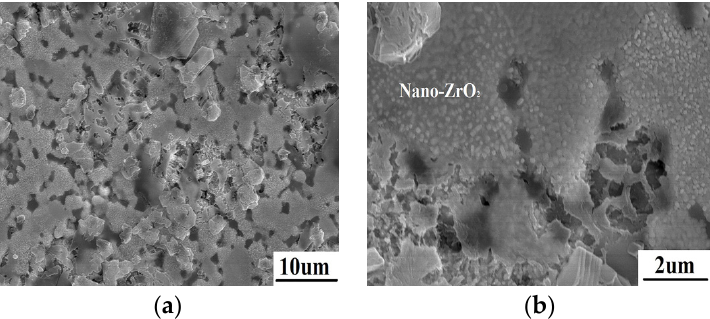
Figure 7. The morphology of ZrB 2 /SiC at the edge after ablation ( a ) with nano ZrO 2 crystals packing on the surface ( b ).